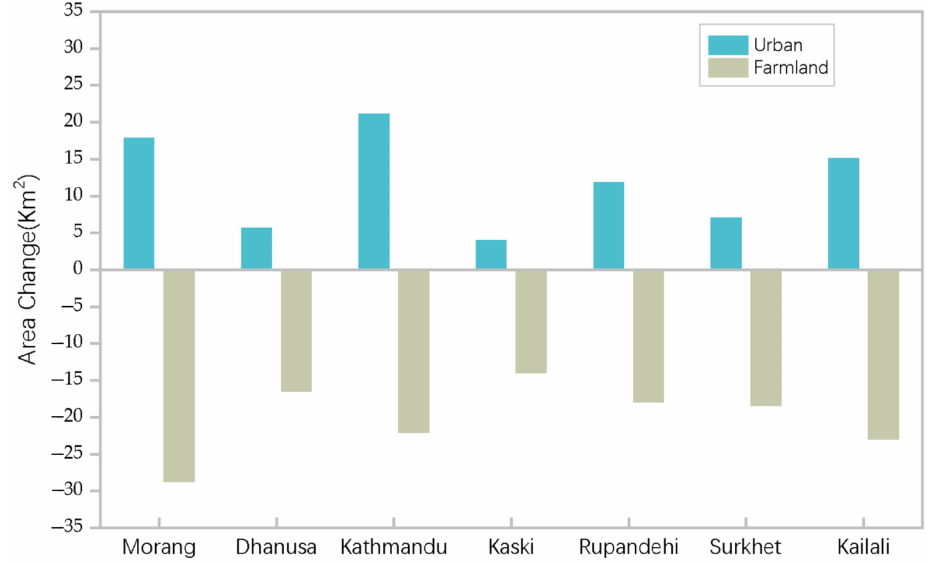
Figure 5. Change of urban and farmland area in seven interest districts from 2016 to